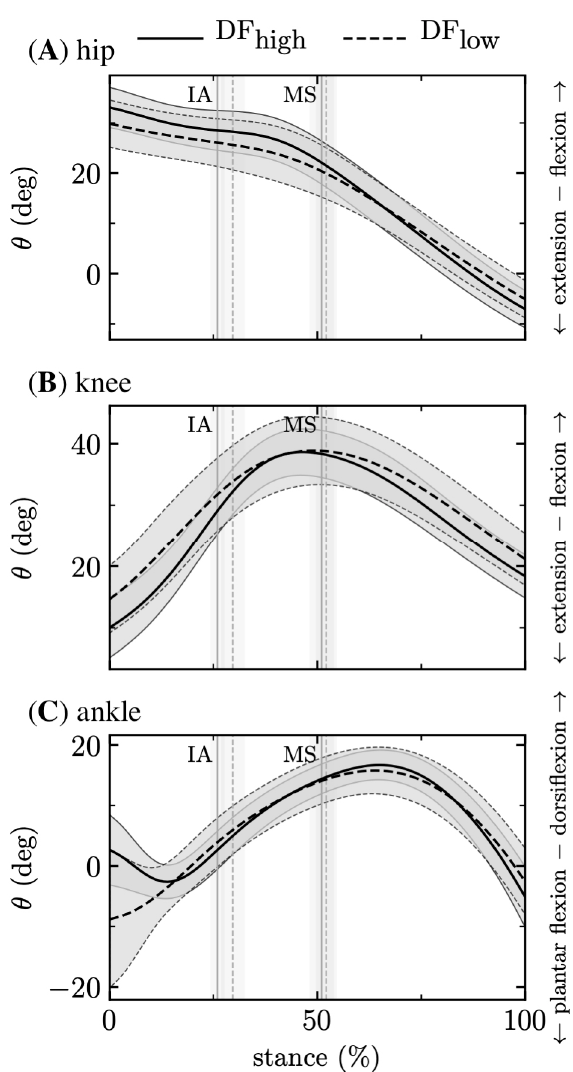
Figure 2. Extension–flexion of the joint angles ( θ ) during the running stance for the high (DF high ) and low (DF low ) duty factor running groups while running at 14 km/h for ( A ) hip, ( B ) knee, and ( C ) ankle joint angle. The running speed is representative of all speed. IA: impact attenuation and MS: mid-stance. A larger plantar flexion was observed at FS for DF low than for DF high (DF groups main e ff ect, p < 0.001; large e ff ect size, d = 1.39; Table 5 and Figure 2C). DF low exhibited more